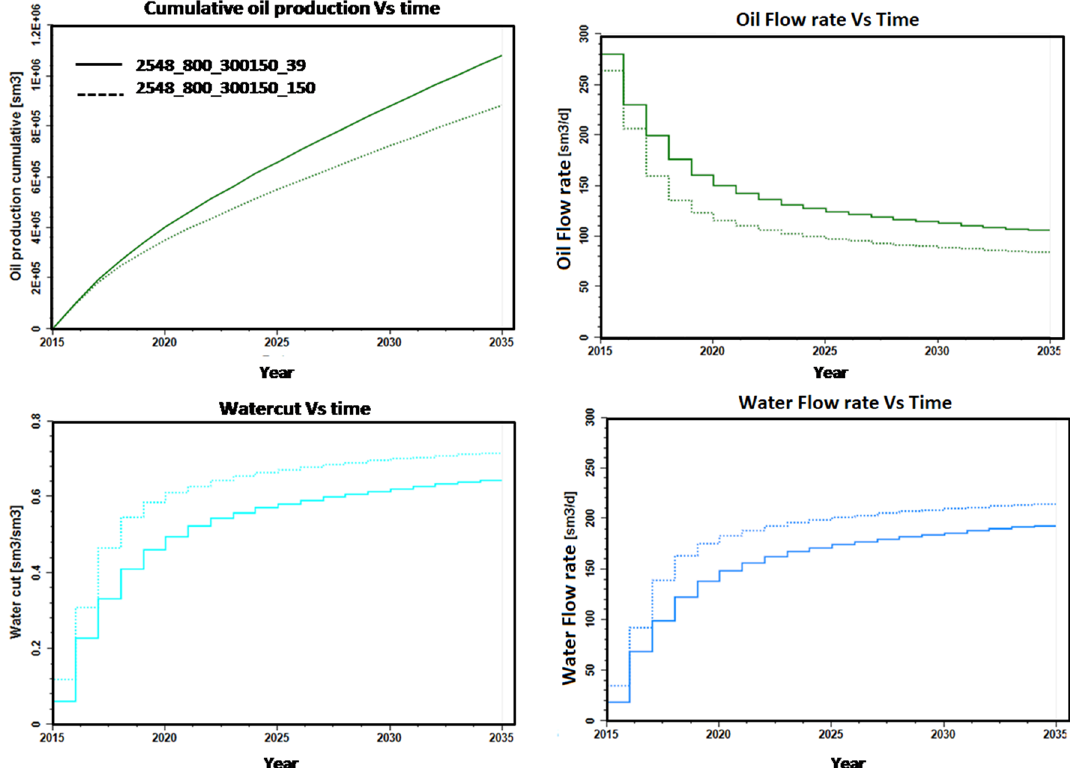
Fig. 11 Production profile comparison of minimum and maximum